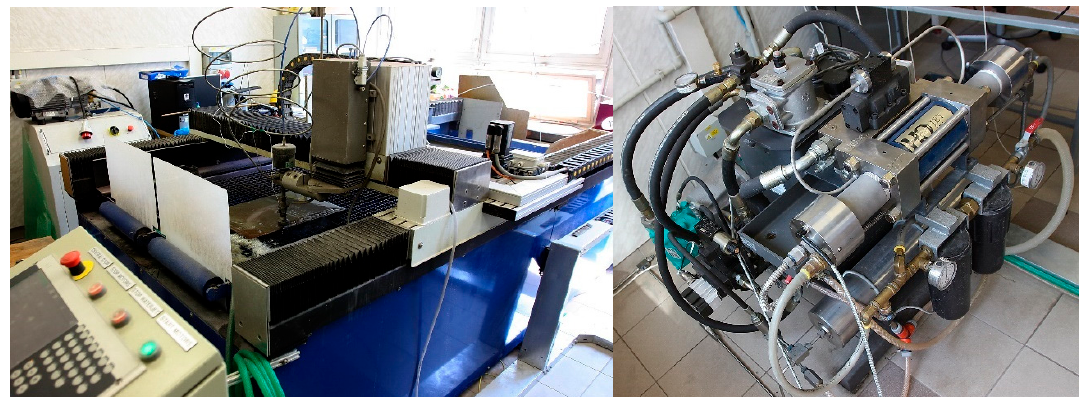
Figure 1. Experimental AWJ system (on the left ) and pump Flow HSQ 5X (on the right ).